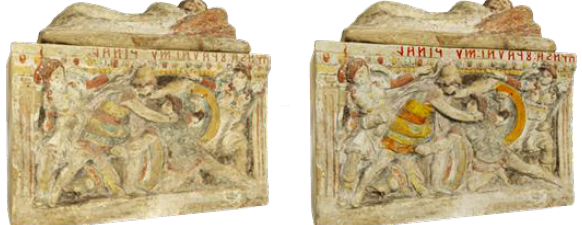
Figure 11: Final Urn rendering, on the left. Final Urn